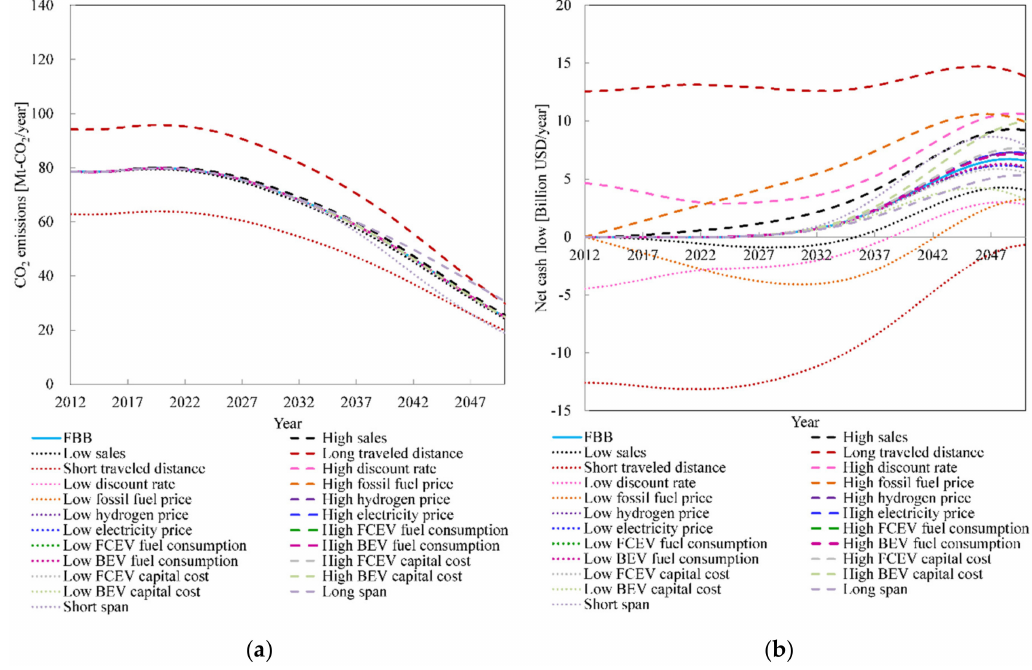
Figure 14. Results of the sensitivity analysis: ( a ) Tank to wheel CO 2 emissions; ( b ) net cash